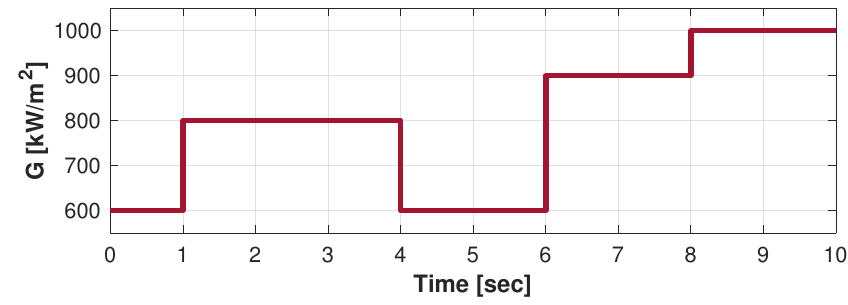
Figure 11. Irradiance profile used for low power simulations.